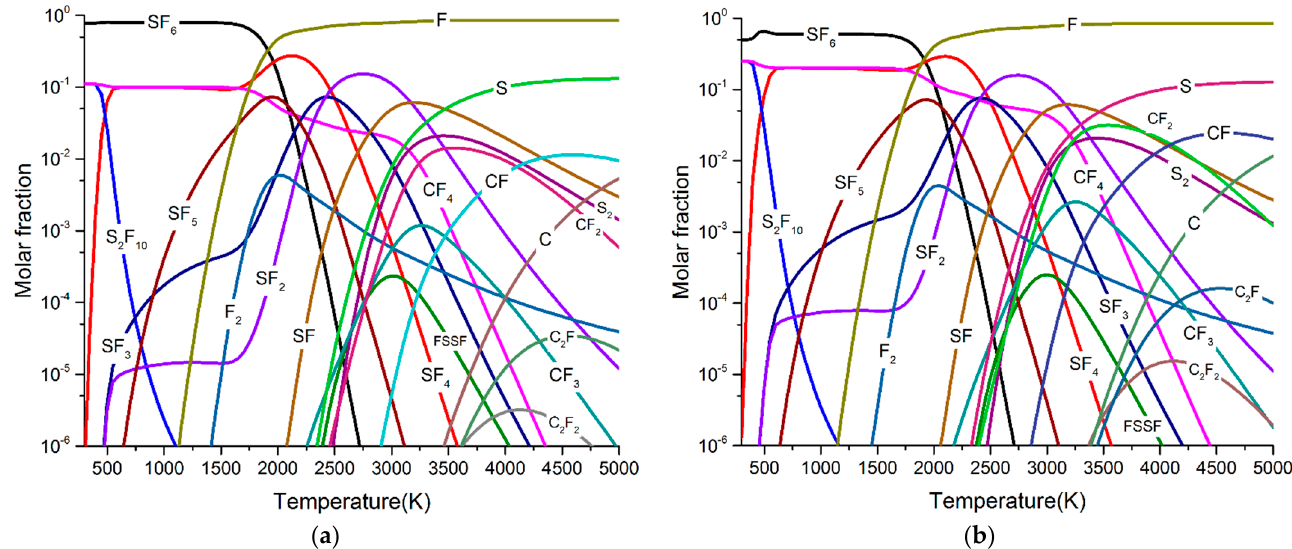
Figure 4. Particle composition of SF 6 /polytetrafluoroethylene (PTFE) arc plasma at 0.6 MPa. ( a ) 90% SF 6 + 10% PTFE. ( b ) 80% SF 6 + 20% PTFE.